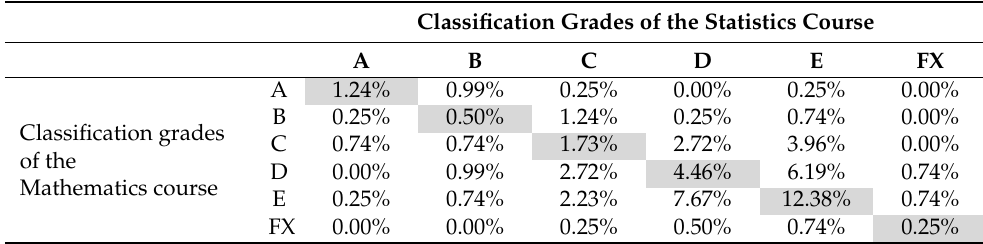
Table 4. Overview of the overall assessment in the Statistics course and the Mathematics course. Classification Grades of the Statistics Course